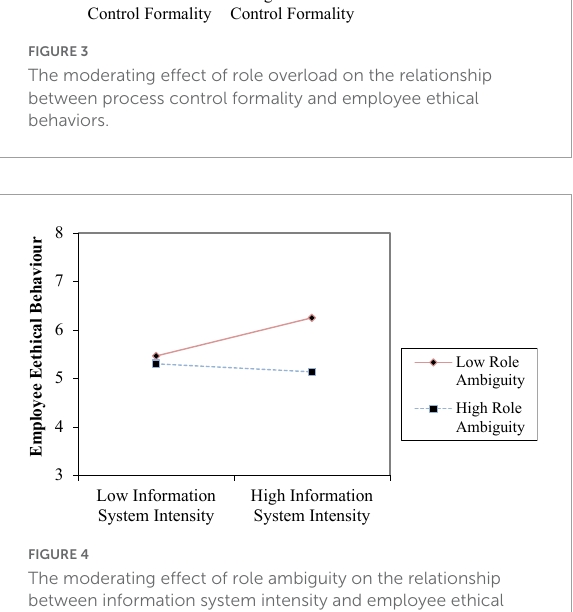
FIGURE4 The moderating effect of role ambiguity on the relationship between information system intensity and employee ethical